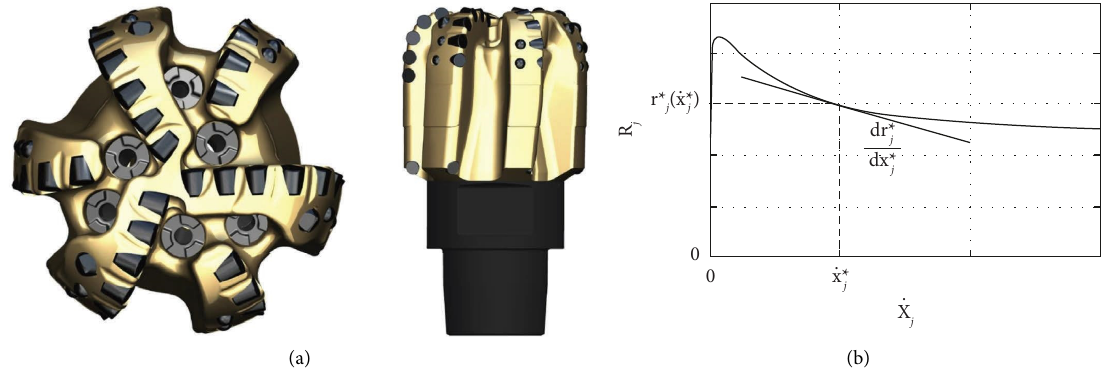
Figure 1: (a) Example of PDC bits; (b) velocity-dependent torque characteristic